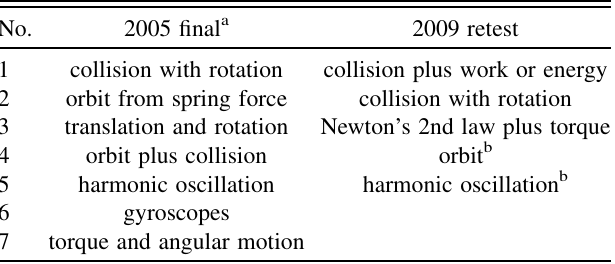
TABLE III. Comparison of the analytic questions on the 2005 final exam with those on the 2009 retest.